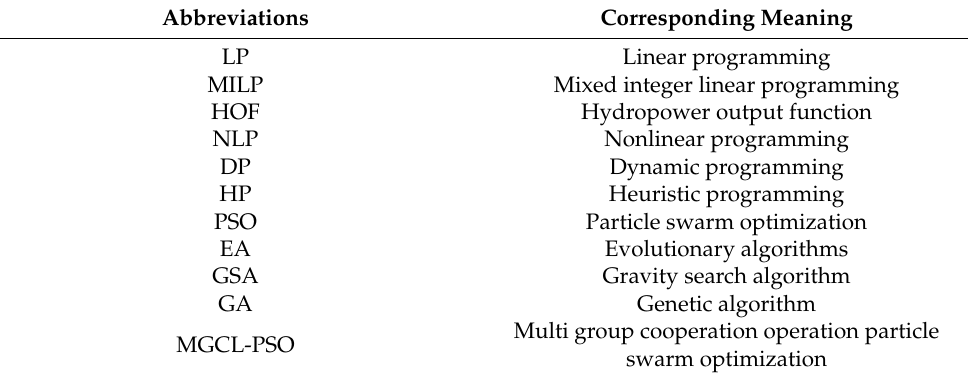
Table 1. Summary of